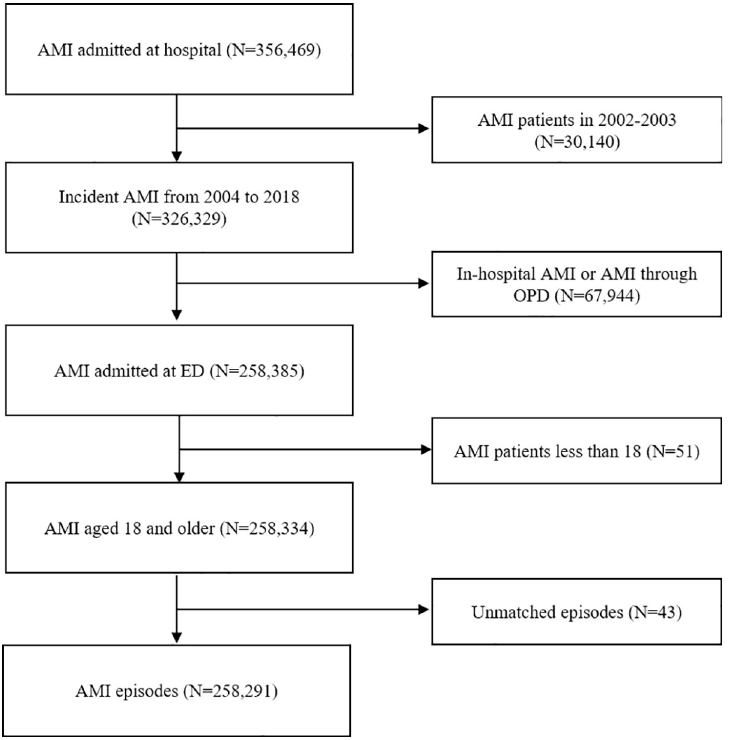
Fig 1. Flowchart of the study inclusion criteria. Abbreviations: AMI, Acute Myocardial Infarction; ED, Emergency Department; OPD, Outpatient Department.